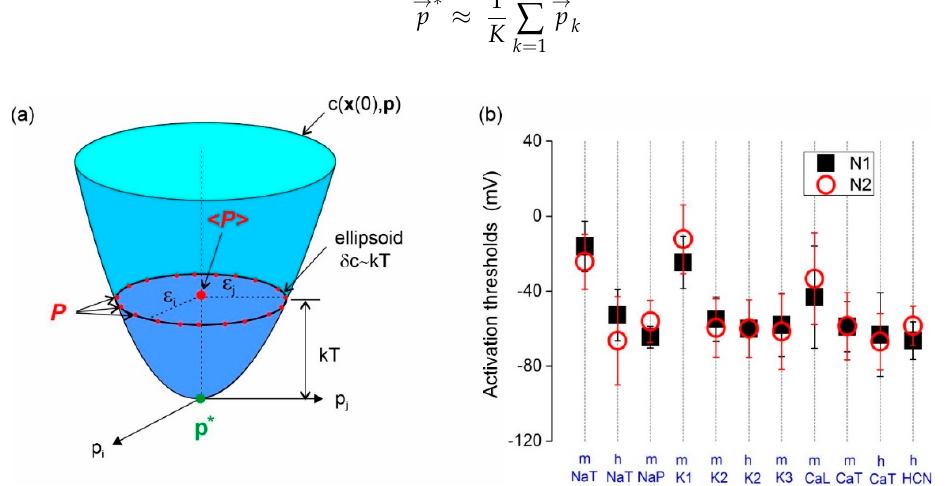
→ Figure 4. ( a ) Schematic of the cost function near the global minimum. The parameters ( 𝑃(cid:4652)⃗ ) estimated P ) estimated Figure 4. ( a ) Schematic of the cost function near the global minimum. The parameters ( from different parameter guesses distribute on the ellipsoid surface 𝛿𝑐 = 𝑘𝑇 . This ellipsoid effec- from different parameter guesses distribute on the ellipsoid surface δ c = kT . This ellipsoid effectively tively broadens the global minimum 𝑝⃗ ∗ proportionally to the error variance. Actual parameters are ∗ → p broadens the global minimum proportionally to the error variance. Actual parameters are approached by averaging 𝑃(cid:4652)⃗ over all initial guesses, since 𝑝⃗ ∗ ≈ 〈𝑃(cid:4652)⃗〉 . ( b ) Activation thresholds (m) → → ∗ → ≈ P over all initial guesses, since p P . ( b ) Activation thresholds (m) approached by averaging and inactivation thresholds (h) obtained by averaging over 84 values of random vector 𝑃(cid:4652)⃗ . The av- → erage thresholds are shown for two interneurons, N1 and N2, of the songbird high vocal center. The P . The and inactivation thresholds (h) obtained by averaging over 84 values of random vector ion channels are transient sodium (NaT), persistent sodium (NaP), potassium (K1), inactivating po- average thresholds are shown for two interneurons, N1 and N2, of the songbird high vocal center. tassium (K3), muscarinic (K3), high threshold calcium (CaL), low threshold calcium (CaT), and hy- The ion channels are transient sodium (NaT), persistent sodium (NaP), potassium (K1), inactivating perpolarization activated channel (HCN) [8]. potassium (K3), muscarinic (K3), high threshold calcium (CaL), low threshold calcium (CaT), and hyperpolarization activated channel (HCN)